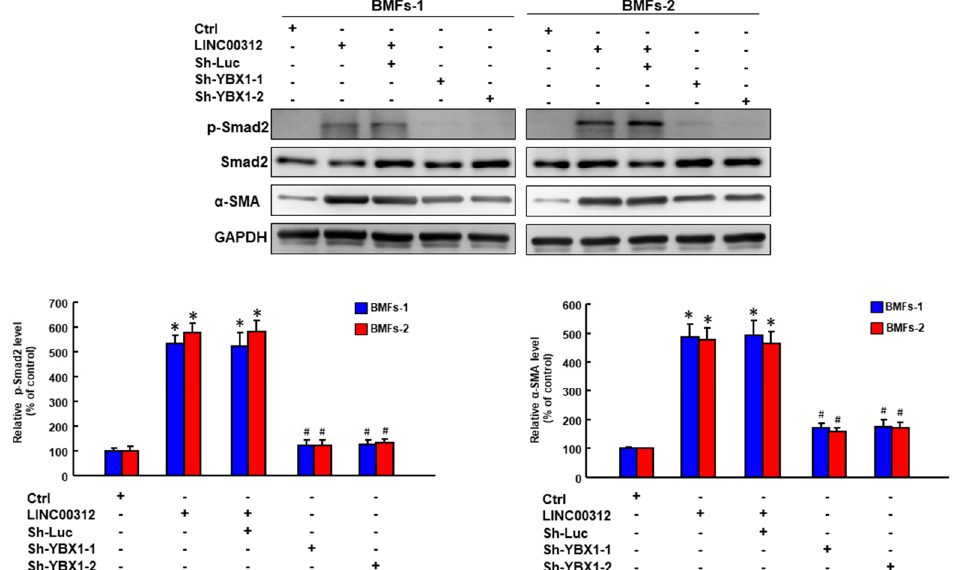
Figure 6. The knockdown of YBX1 reverses the LINC00312-increased α -SMA and p-SMAD2 in BMFs. The expression levels of α -SMA and p-SMAD2 as indicated transfections presented by the Western blotting analysis. * p < 0.05 compared to the control group. # p < 0.05 compared to the LINC00312+Sh- Luc group.